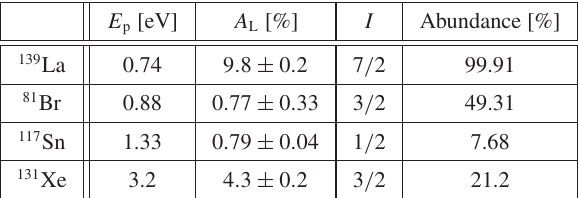
Figure 2. φ dependencies of κ ( J ) for the target isotopes 139 La, 131 Xe, 81 Br and 117 Sn. Table 1. Properties of the candidate nuclei for the T-violation search. The nuclear polarization method has not yet been established except for 139 La and 131